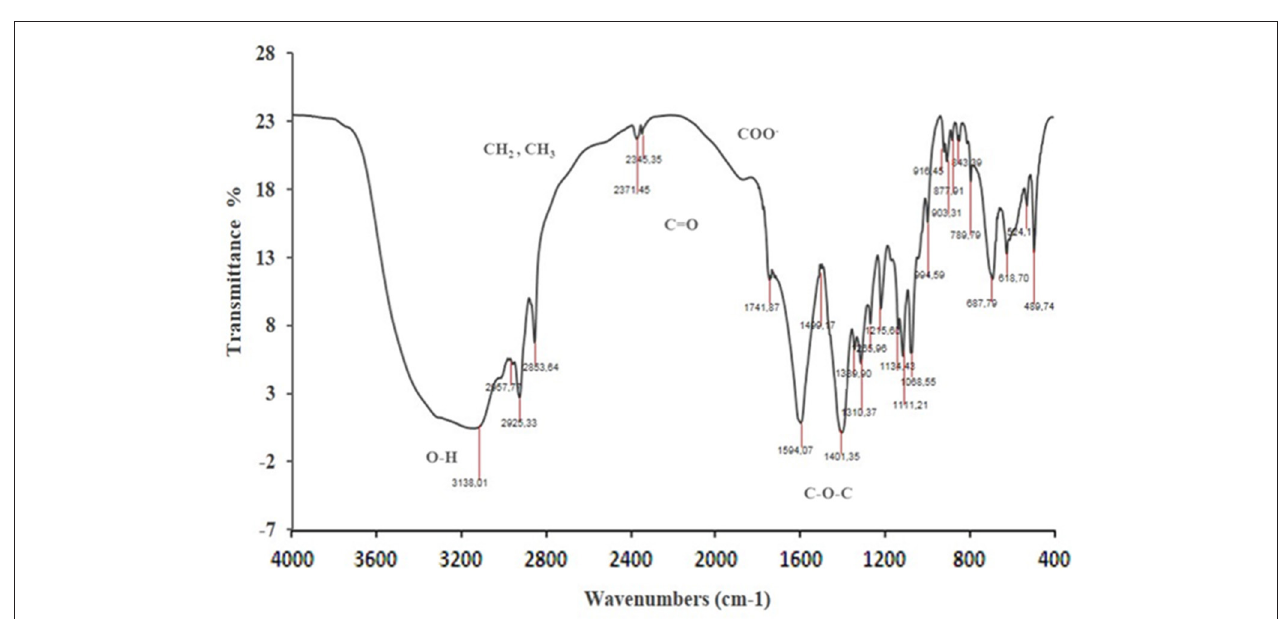
FIGURE 7 | Fourier Transform InfraRed spectroscopy analysis of BS produced by P. rhizophila S211.